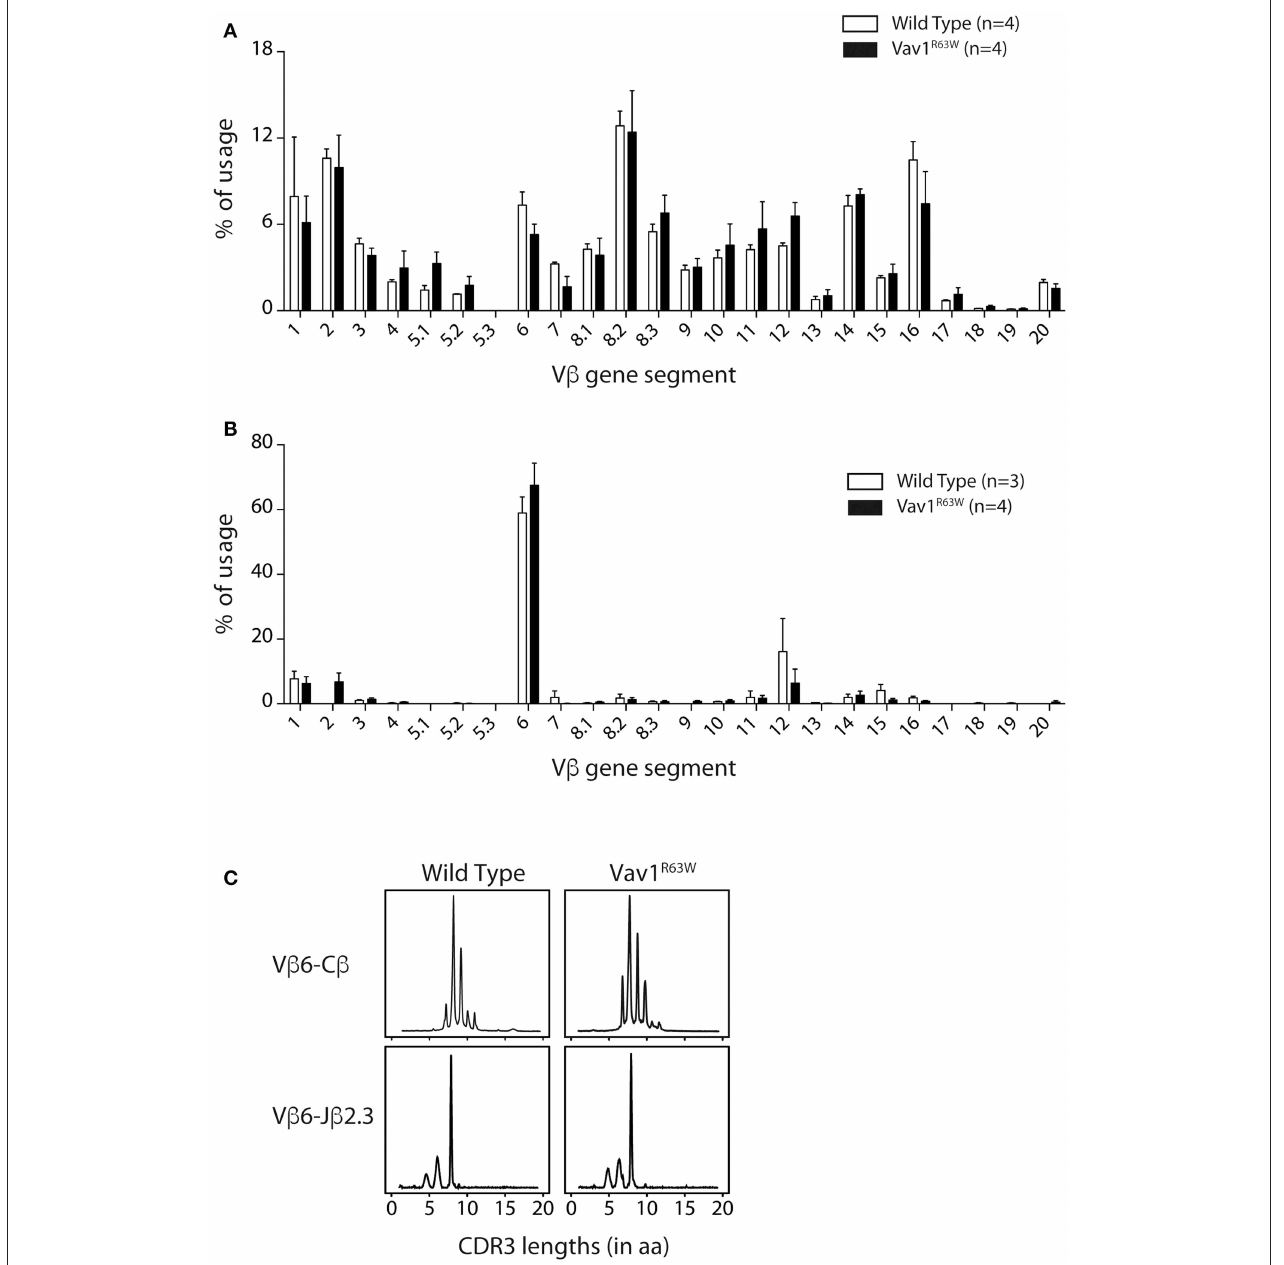
FIGURE 6 | Vß gene segment usage and CDR3 size distribution of α 146-162 AChR-specific CD4 + T cells from WT and Vav1 R63W mice. Nine days after sub-cutaneous immunization, draining LN were harvested and tAChR-specific activated CD4 + T cells (AChR I-A b tetramer + CD44 + ) were FACS sorted out prior to RNA isolation and RT-coupled real time PCR analysis. Alternatively, lymph node CD4 + T cells were isolated from naive mice. V β gene usage for naive (A) and tAChR-specific CD4 + T cells (B) isolated from WT (white) or Vav1 R63W (black) mice are depicted. CDR3b size distributions from one representative sample of each background are presented (C) . Rearrangements shown are Vß6-Cß and Vß6-J α 2.3.